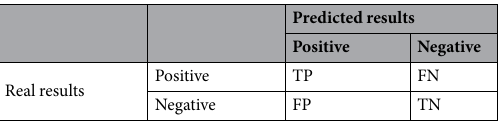
Table 3. Confusion matrix obtained from classifier.